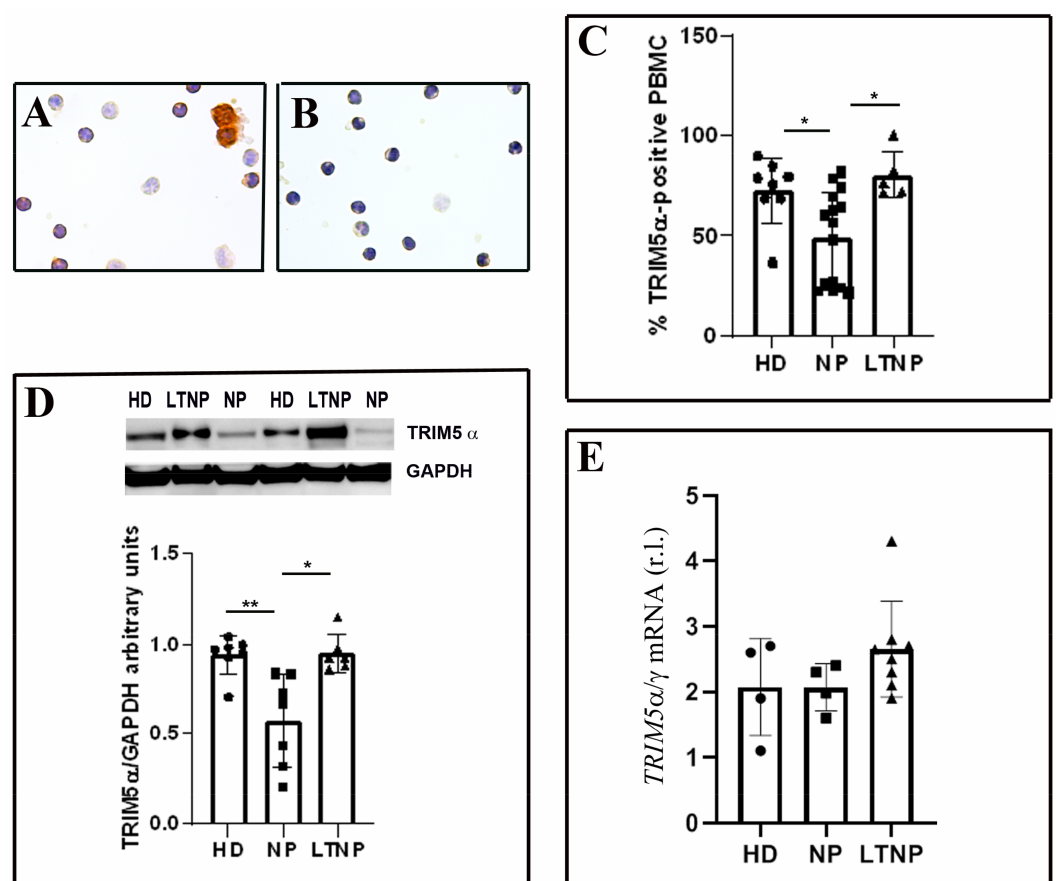
Figure 1. Enhanced expression of TRIM5 α in PBMC from LTNP compared to NP. ( A ) Immunocytochemical localization of TRIM5 α on PBMC from LTNP (Patient No. 3). ( B ) Negative control. ( C ) The percentage of cells expressing TRIM5 α was quantified on PBMC from 15 NP (All enrolled patients), 5 LTNP (Patients No. 1, 2, 4, 6, and 9) and 8 HD, and a minimum of 500 PBMC/patient were analyzed. ( D ) WB analysis of TRIM5 α levels on PBMC from 7 HD, 7 NP (Patients No. 4, 6, 8, 9, 13, 14, and 15) and 6 LTNP (Patients No. 1, 2, 3, 4, 7, and 10). The mean values of 3 different experiments are reported in the graph. ( E ) qPCR of TRIM5 mRNA relative level on PBMC from 4 NP (Patients No. 3, 5, 12, and 14), 8 LTNP (Patients No. 1–5, 7, 9, and 10) and 4 HD. The mean values of 4 different experiments are reported in the graph. Data are reported as scatter plots with means values ± s.d. * p < 0.05, ** p < 0.01. HD, healthy donors; NP, HIV-1-infected normal progressor patients; LTNP, long-term nonprogressors. Original magnification: A, B, 40 ×